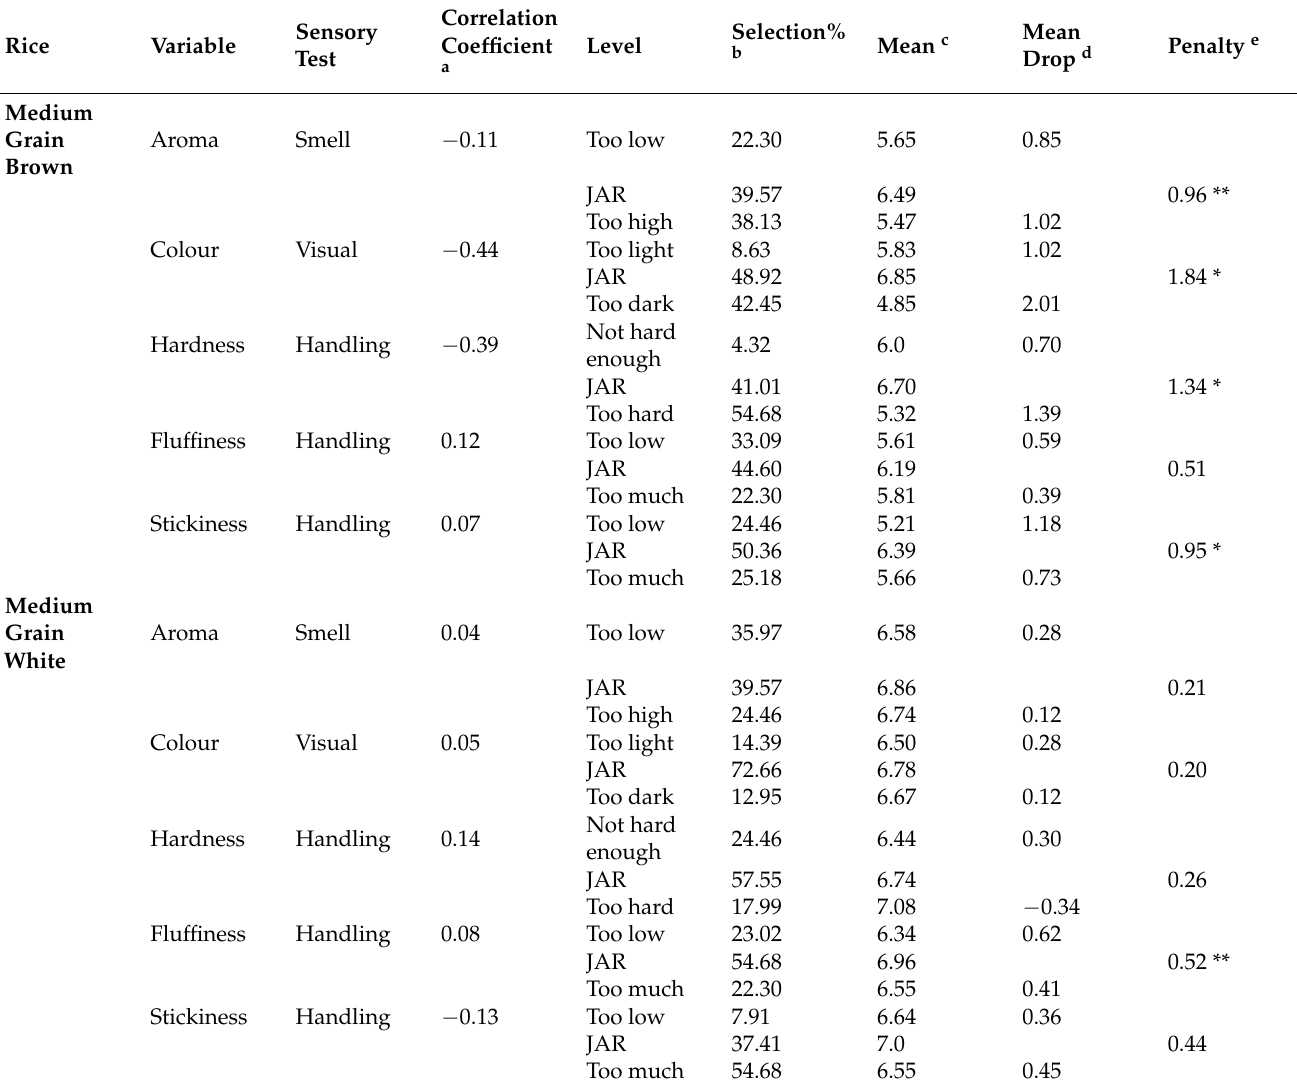
Table 7. The Penalty analysis and JAR variables (before tasting) for Medium grain brown and Medium grain white rice.